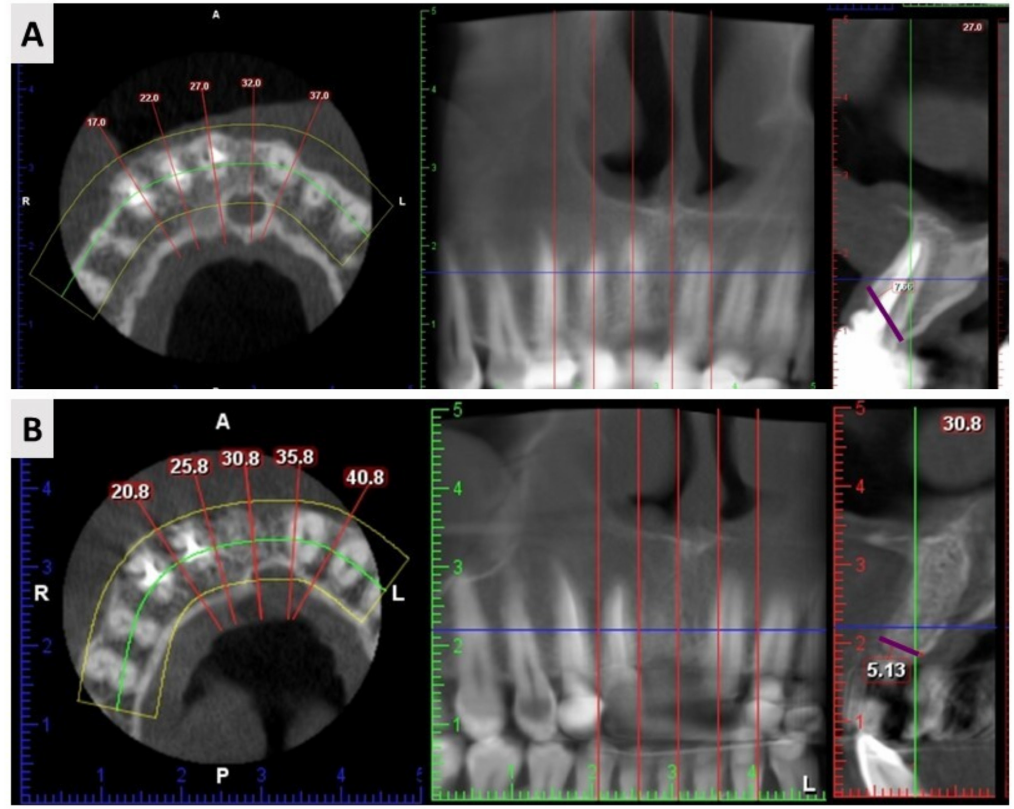
Figure 7. CBCT assessment protocol. The buccolingual dimension was measured between the most prominent points buccally and orally (purple marked line) at two time points—before extraction ( A ) and four months after ( B